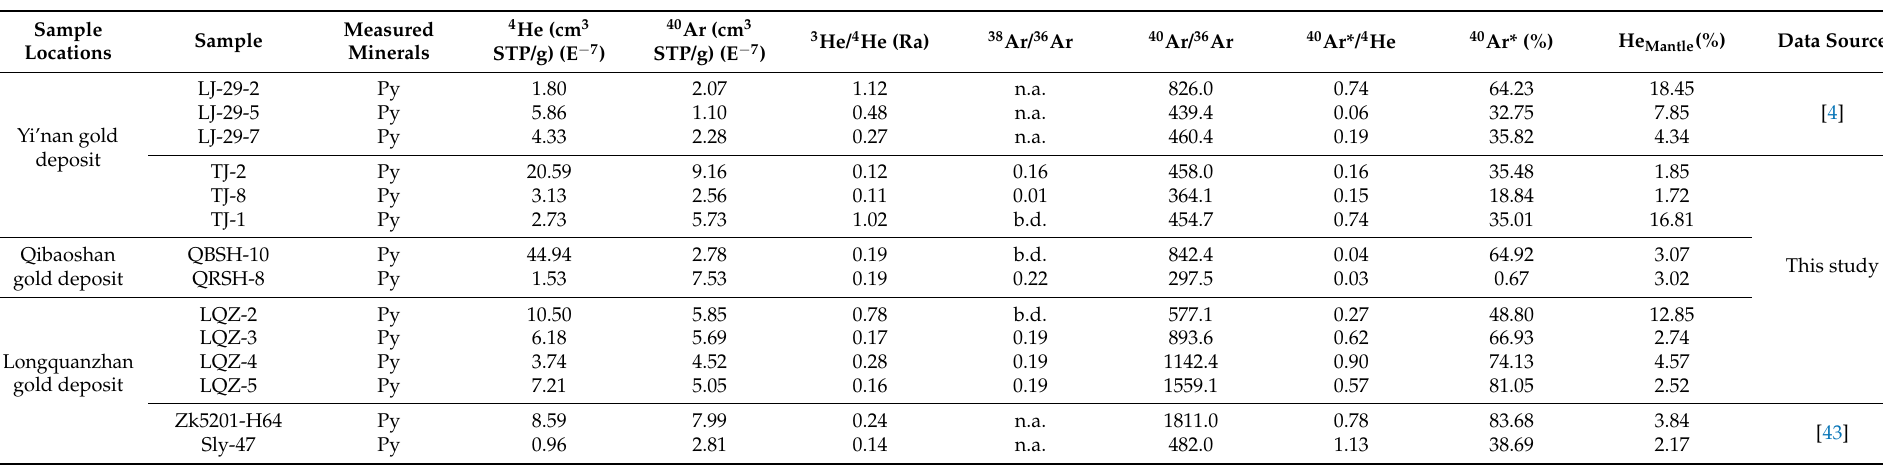
Table 2. He and Ar isotopic compositions of inclusion-trapped fluid in pyrites from the Longquanzhan, Yi’nan, and Qibaoshan gold